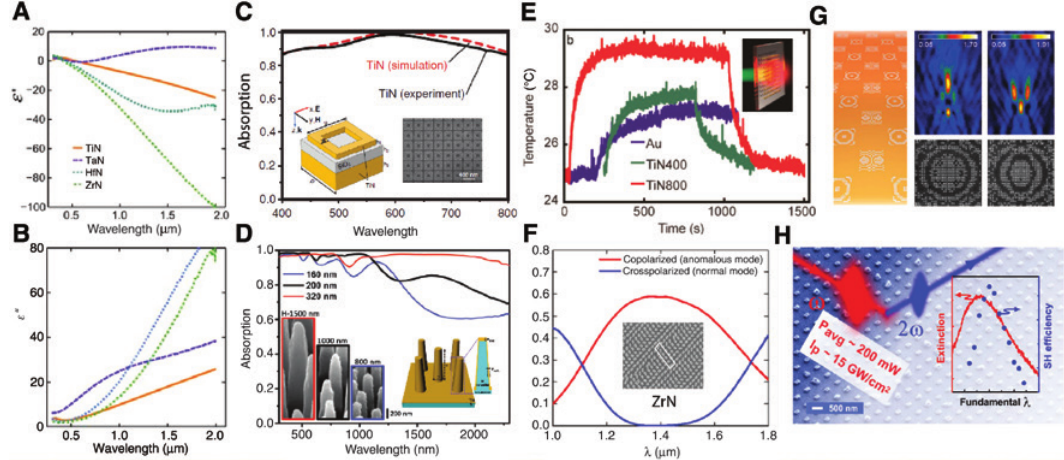
Figure 2: Examples of TiN based metasurfaces. (A)–(B) Measured optical properties [real (A) and imaginary (B) parts of the dielectric permittivity] for various different transition metal nitrides, e.g. TiN, ZrN, hafnium nitride (HfN), and tantalum nitride (TaN) [80]. (C) Simulated (dashed line) and measured (solid line) absorp- tion spectra for the TiN MM absorber. (Inset – left) Schematic representation of a unit cell of the three-layer TiN MM absorber with = 30 nm, h = 60 nm, and h = 150 nm; (inset – right) SEM image of the dimensions of a = 250 nm, w = 50 nm, p = 300 nm, h 1 2 3